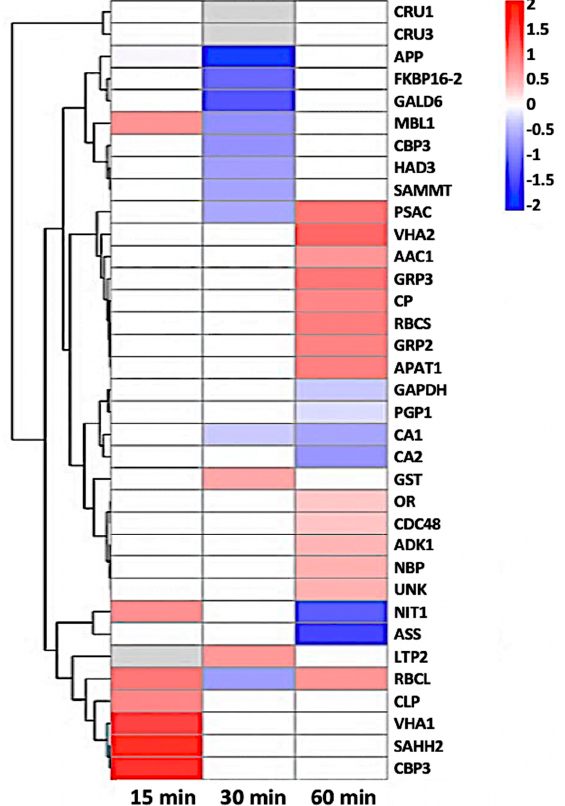
Figure 7. Heat-map of 35 nitrosylated proteins obtained by hierarchical clustering. The columns represent different time point ratios of treatment/control. The rows represent individual proteins. Protein AGI numbers are listed to the right. The increased and decreased proteins are represented in red or green, respectively. The color intensity increases with increasing differences, as shown in the scale bar. Please refer to Table 1 for detailed information.